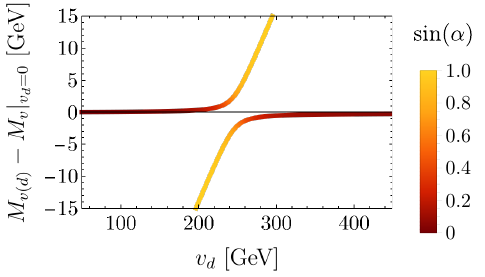
Figure 9 . Eigenvalues of the mass matrix as a function of the dark scalar vacuum expectation value for a fiducial set of IR quartic couplings λ choose these values as examples to illustrate the mixing between the two scalars. The overlap of the mass eigenstate with the dark scalar is colour coded. (The sine of the mixing angle by convention corresponds to the overlap of the heavier mass eigenstate with the dark